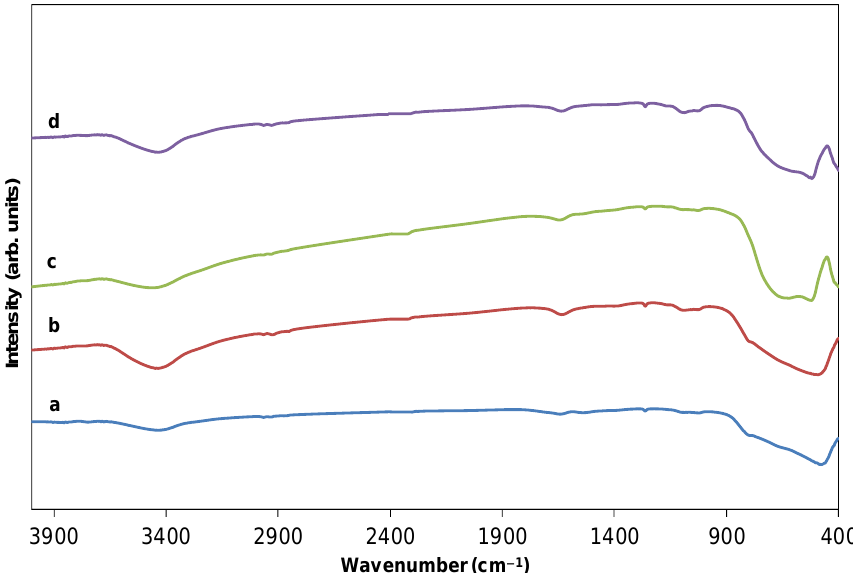
Figure 3. Normalized IR spectra of 0.00%_550 and 1.70%_550 (a) and (b), respectively, and 0.00%_1000 and 1.70%_1000 (c) and (d), respectively. After hydrolysis and polycondensation, another color change from light brown to dark brown is observed for the particles. Figure 4 shows FEG-SEM pictures of the tem- plate + TiCl 4 and TbCl 3 mixture + HCl (aq) after 5 h of reaction for the 0.12 at.% Tb sample (a) and the same HSs after 7 h of reaction and calcination at 550 ° C for 30 min (b). The presence of Cl − in the intermediate compounds before washing and calcination as well as the presence of both Ti and Tb was confirmed by XEDS (Figure S2). Figure 4b shows a uniform hollow Tb-doped TiO 2 microsphere with an outer average diameter size of 1.8 ± 0.2 µm, confirmed by TEM (Figure 5a). The size of the spheres after calcination at 550 ° C suffers a shrinkage process of approximately 37% when compared with uncalcined spheres. A rough surface is noted related to the presence of aggregates of nanoparticles. In addition, the average shell thickness of the HSs is 64.0 ± 0.2 nm (Figure 5a). The SAED diagram shown in Figure 5b provides a direct evidence of the structure of the material which corresponds to anatase phase according to XRD results (see below in Section 2.2.)